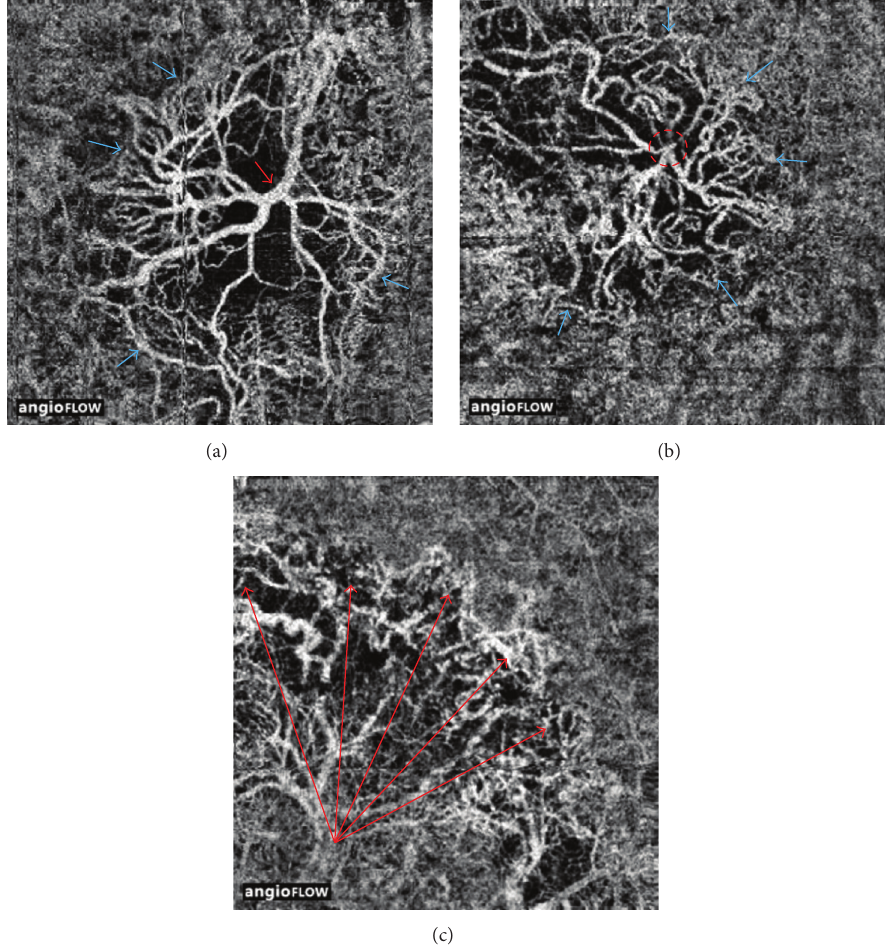
Figure 5: Optical coherence tomography angiography (OCTA) of treated choroidal neovascularization. (a) A 3 ∗ 3 -mm OCTA en face projection image from an 84-year-old man who was treated with 20 intravitreal anti-VEGF injections. Note the large diameter of the trunk vessels (red arrow). At the periphery there appears to be a defined anastomotic connection around the border (blue arrows). (b) A 3 ∗ 3 - mm En face angiogram of the neovascular membrane from a 65-year-old man who were previously treated with 18 intravitreal anti-VEGF injections showing the red dashed circle that encompasses the trunk vessels of the lesion. Note the neovascular complex with vessels radiating in all directions from the center and the terminal loops of the vessels (blue arrows). (c) A 3 ∗ 3 -mm OCTA en face projection image from a 65-year-old man who were treated with 16 intravitreal anti-VEGF injections. Note the long extent of the vessels as they reach the edge of the lesion (red